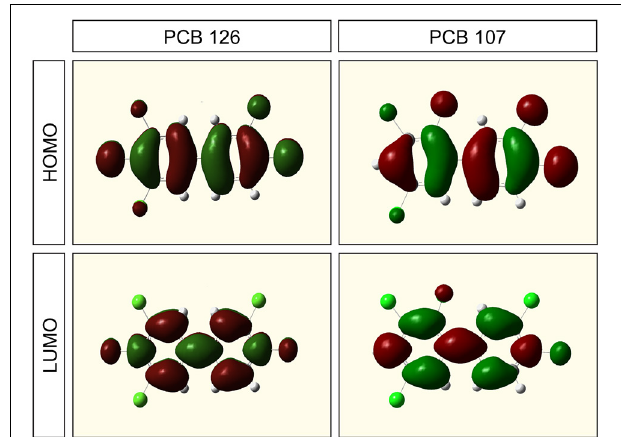
FIGURE 2 | HOMO and LUMO isosurfaces of PCBs. The HOMO and LUMO isosurfaces of PCB 126 and PCB-107.